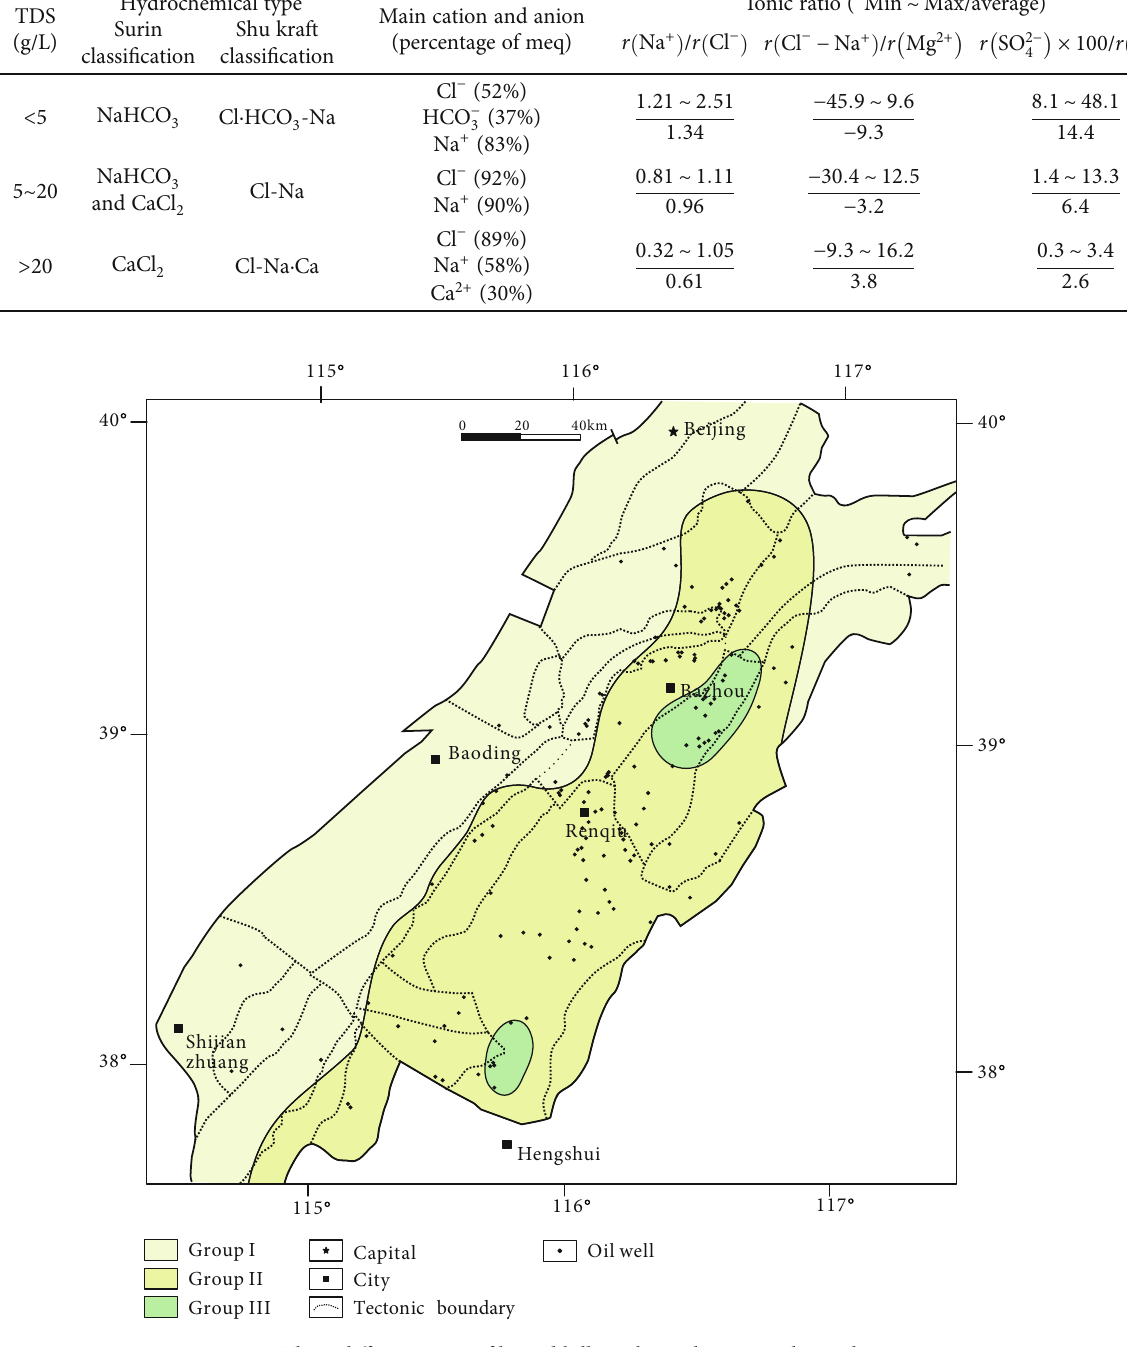
Figure 7: Three di ff erent types of buried hill geothermal water in the study